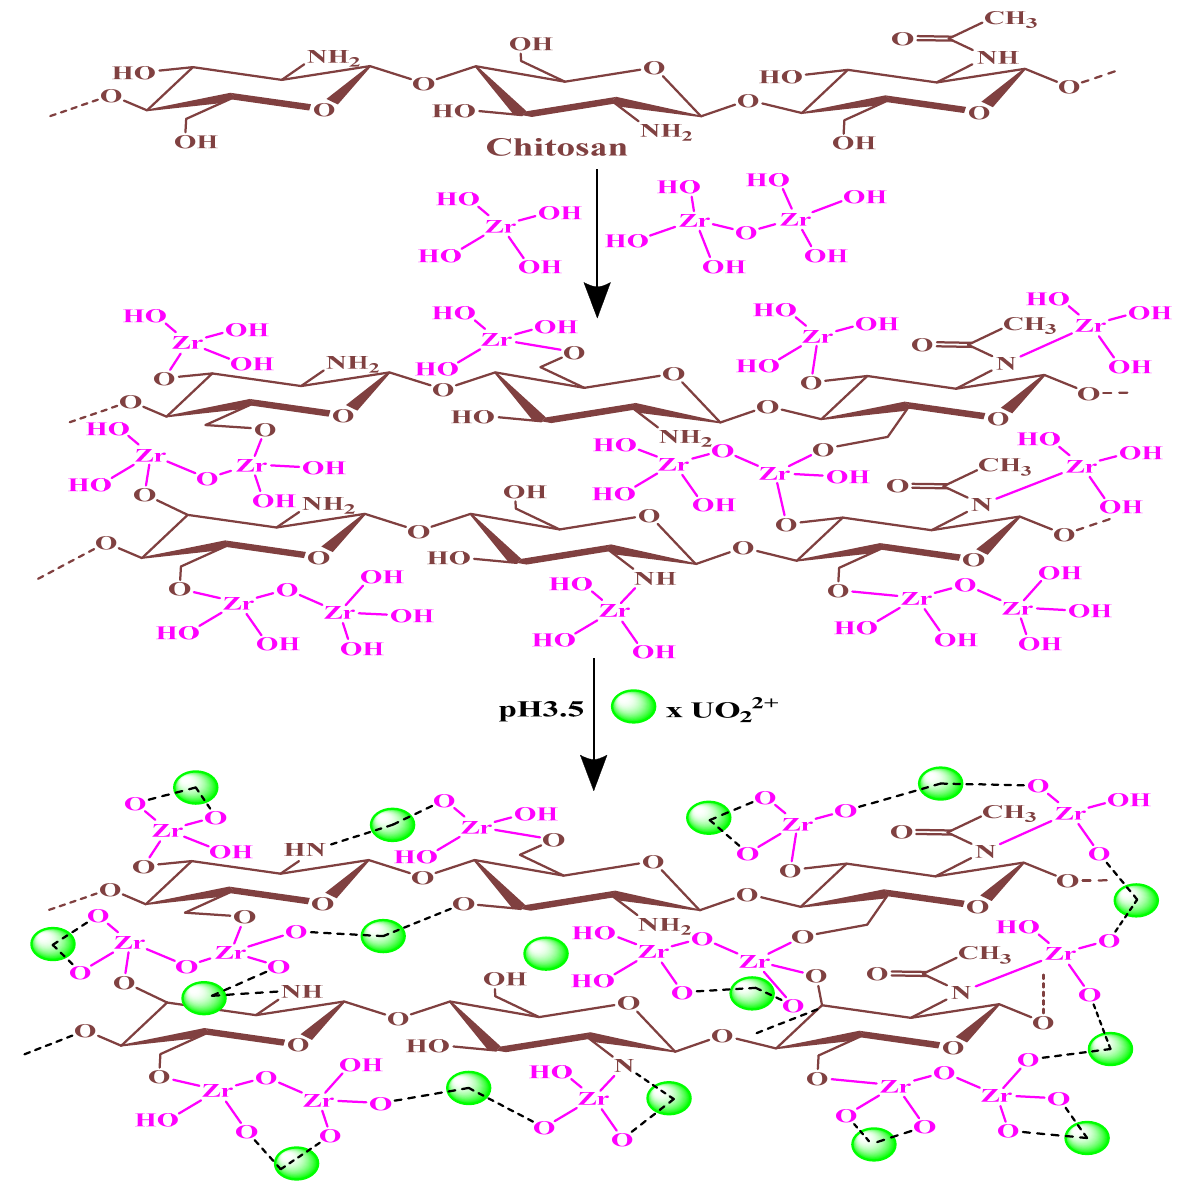
Figure 10. Depicts the theoretical ZrO 2 /CS and uranium cation interactions.